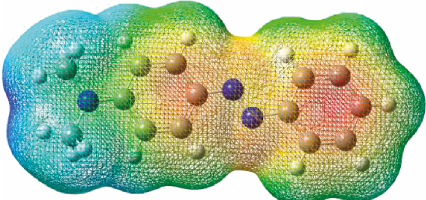
Figure 8: Molecular electrostatic potential mapped on the isodensity surface for DMAB calculated by